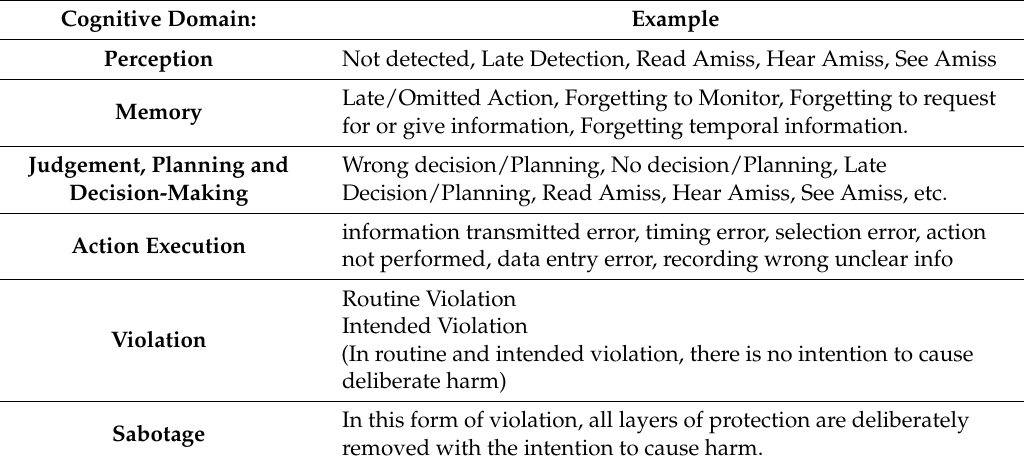
Table 6. Internal Error Mode Taxonomy observable outcomes.